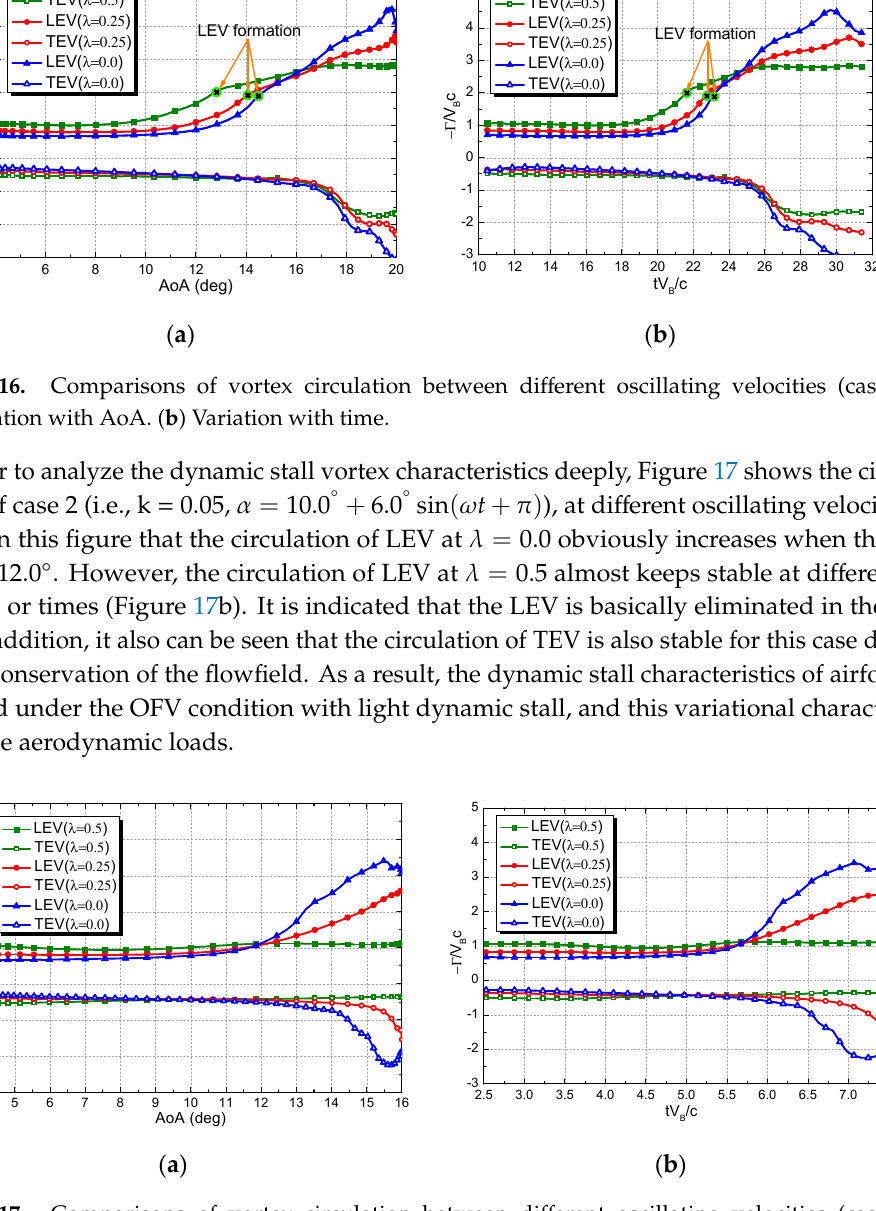
Figure 17. Comparisons of vortex circulation between different oscillating velocities (case 2). ( a ) Variation with AoA. ( b ) Variation with time.